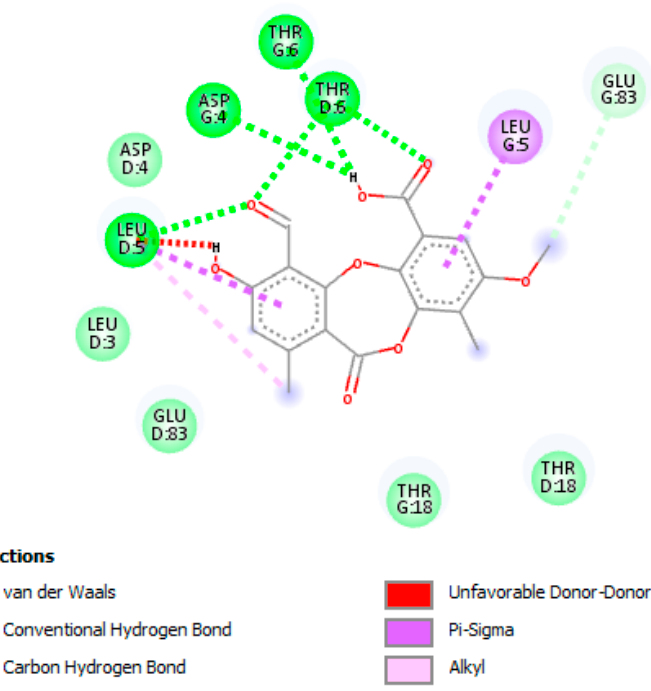
Figure 4. A two-dimensional interaction diagram of psoromic acid (PA) in the active site of arylamine-N-acetyltransferase (TBNAT). Only those amino acid residues involved in TBNAT stabilization are shown. Hydrogen bonding and several essential interactions with amino acid residues are shown.